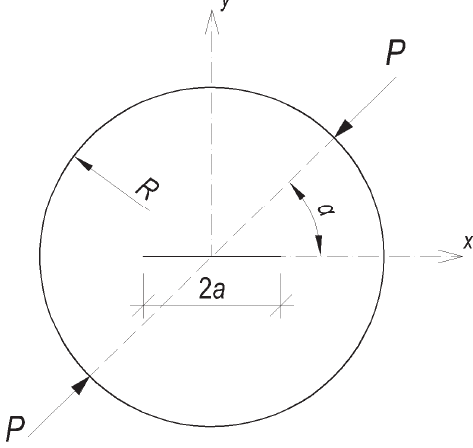
Figure 1: Geometry of a typical Brazilian disc specimen with load position alongside